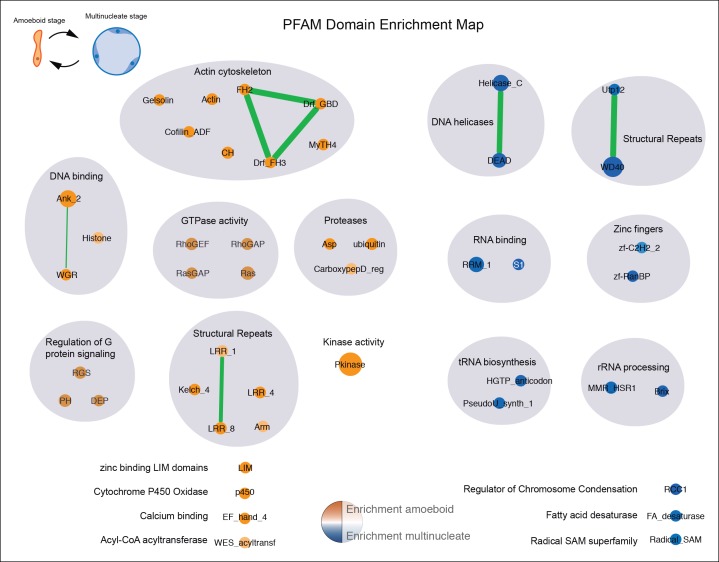
Pfam domain set enrichments in differentially expressed genes.Orange represents domains enriched in the amoeboid stage and blue represents domains enriched in the multinucleate stage, color intensity depicts level of significance (p value, Fisher’s exact test). Node size represents the total number of genes containing a Pfam domain and edge width represents the total number of genes sharing two distinct Pfam domains. Functionally related Pfams are manually circled in gray shade, primarily based on the information gathered in the Pfam database for each domain (including Pfam2Go annotations). Additional criteria to include a given domain in a functionally related category included: checking the list of GOs of the statistically differentially expressed domain-containing genes in a given stage and using a network connectivity redundancy between GO and Pfam categories in a mixed network (including both Pfam and GO annotation) done with Enrichment Map plugin in Cytoscape (Merico et al., 2010). GO, Gene Ontologies.